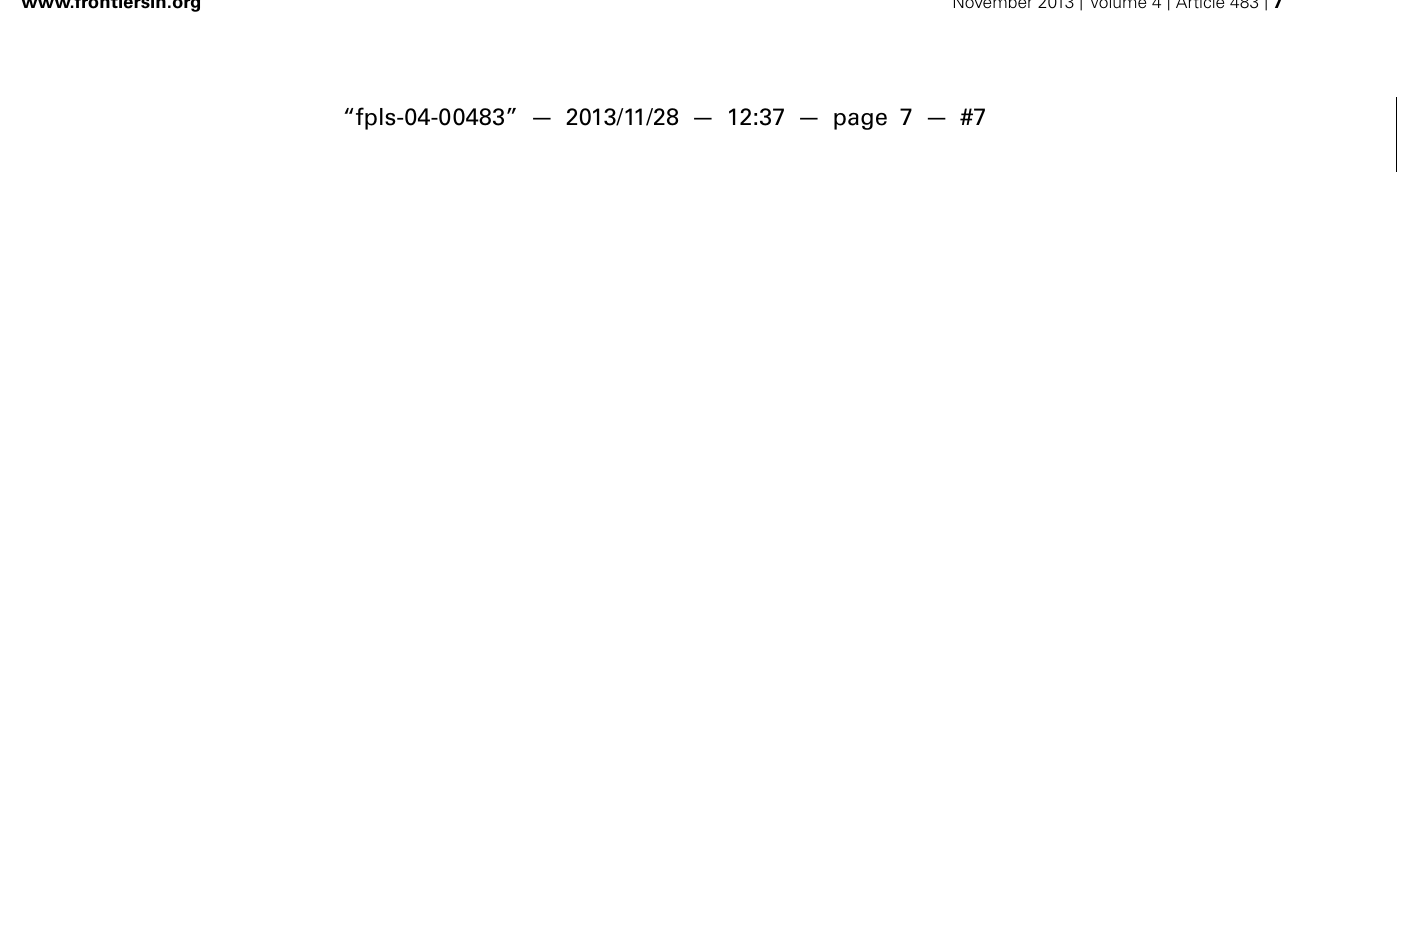
conditions of non-limiting carbon availability, and was considered as the control (Poiroux-Gonord etal., 2013). For masses and carbohydrate measurements, five fruits per level of leaf-to-fruit ratio were collected regularly in the morning (10:00, local time) from September to March during the 2008–2009 season. Error bars are 95% confidence